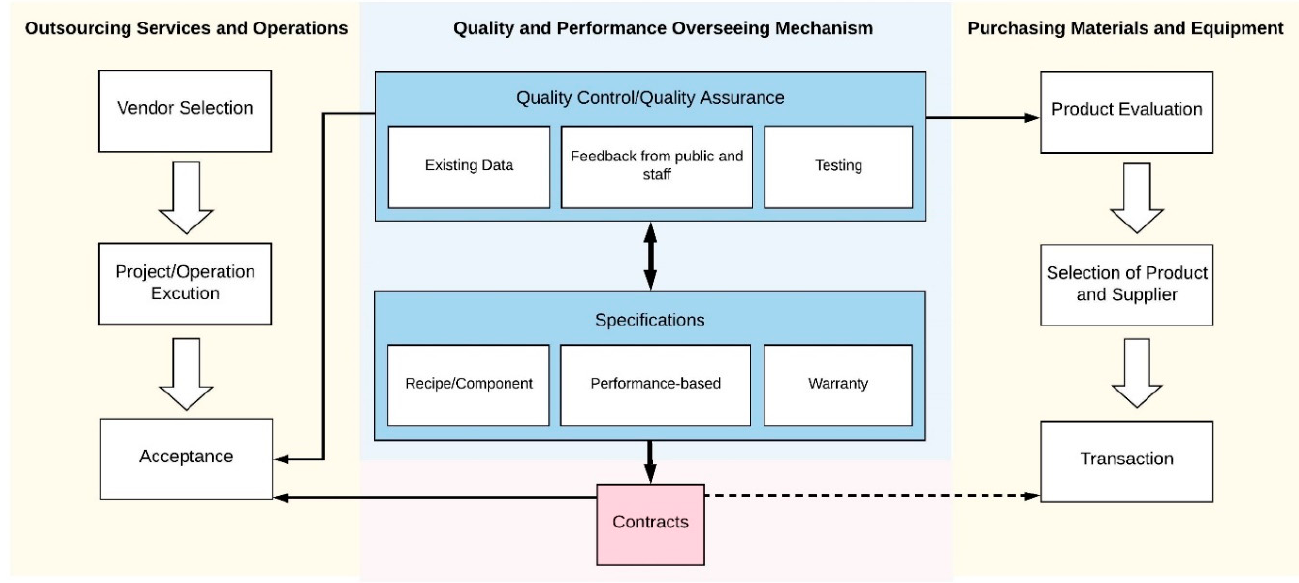
Figure 4. PMMS elements for quality management in the acquisition of goods and services. Contracts are technically the main enforcing component of the quality assurance process. In addition to services and operations, contracts might also be used in mate- rial/equipment purchases to guarantee quality; it is shown in Figure 4 with a dashed line because not all purchase transactions are closed with performance-controlling